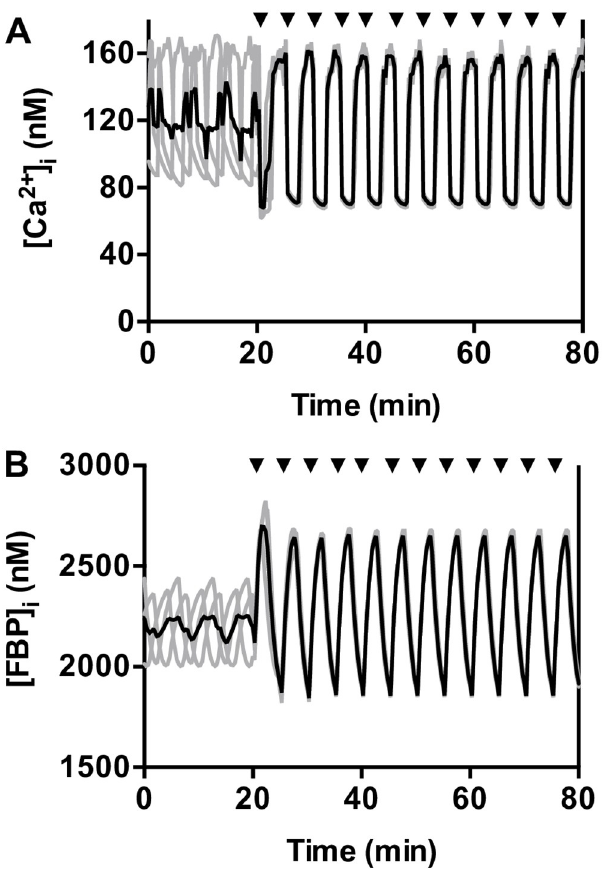
Fig 6. Model islets are synchronized by exposure to IP 3 pulses with rest period R = 5 min. The time courses of the three model islets are in gray, and the mean is in black. An IP 3 pulse is applied at each arrow. (A) Ca 2+ traces quickly synchronize when IP 3 stimulation begins. (B) The glycolytic metabolite FBP also synchronizes.